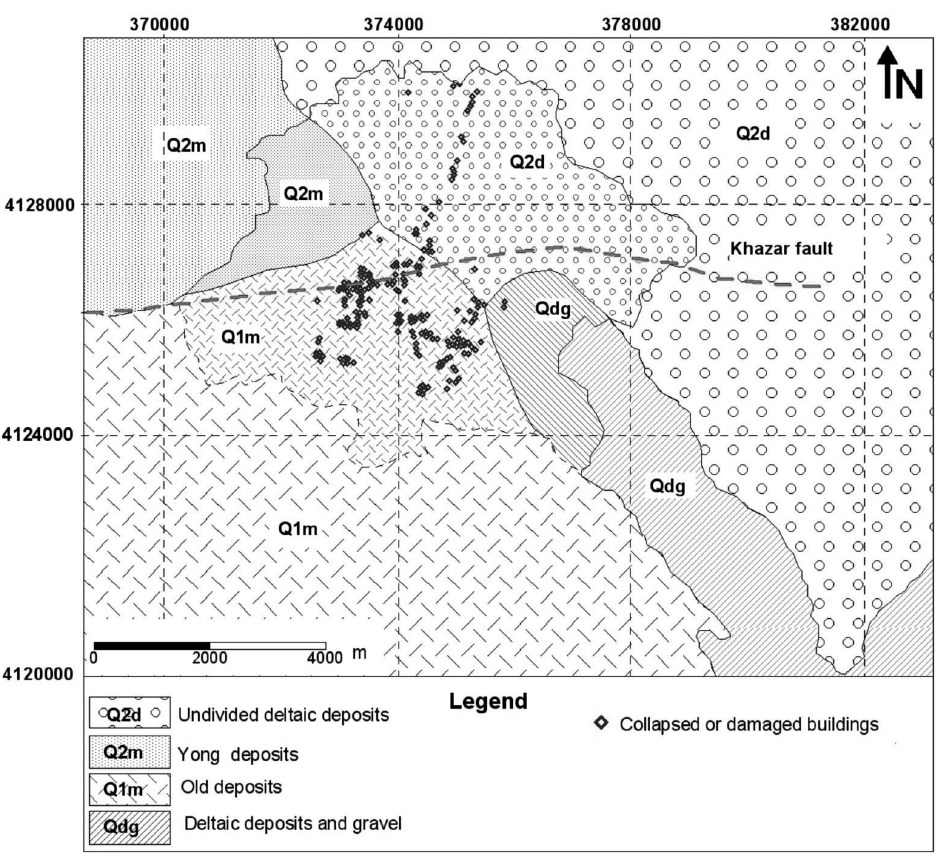
Fig. 9. The boundary of sedimentary units in study